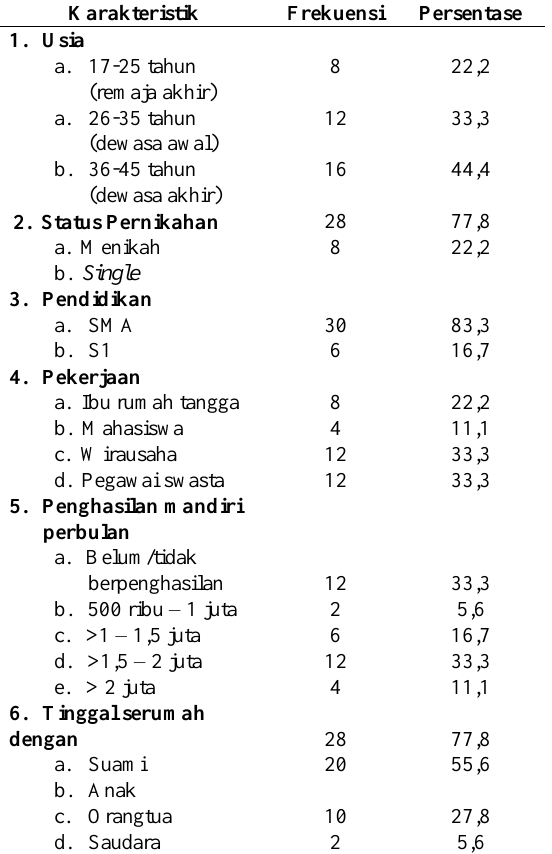
Tabel 2. Data Demografi Responden